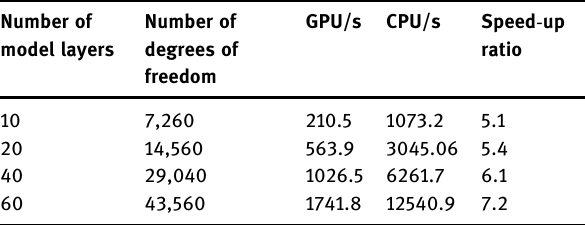
Table 3: Calculation time